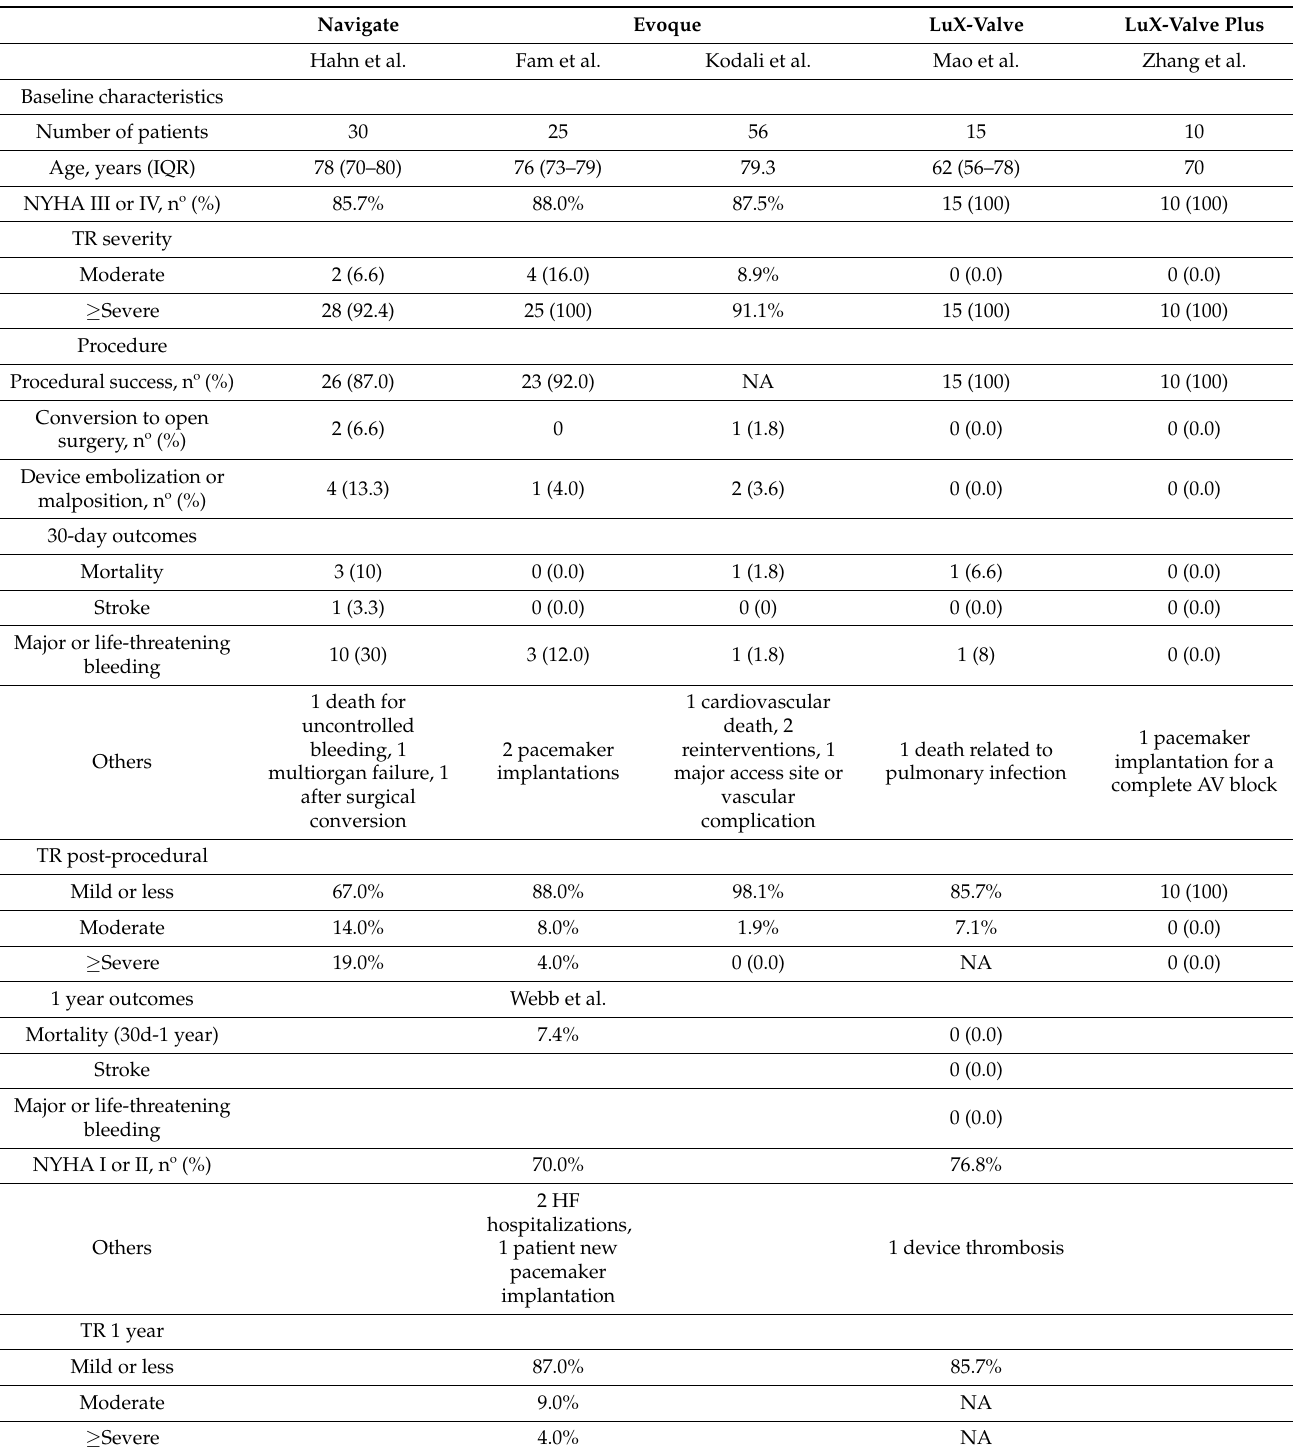
Table 2. Procedural and clinical outcomes of transcatheter tricuspid valve replacement devices with larger reported